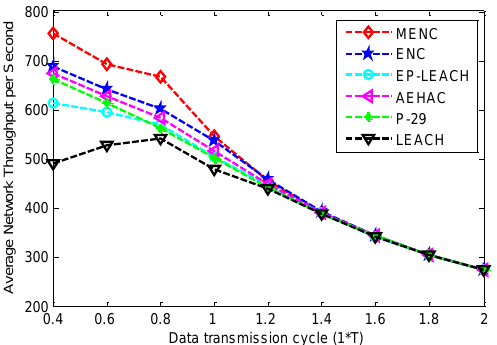
Figure 7. The comparison of ANTS among MENC, ENC, EP-LEACH, AEHAC, P-29 and LEACH for different data transmission cycles.